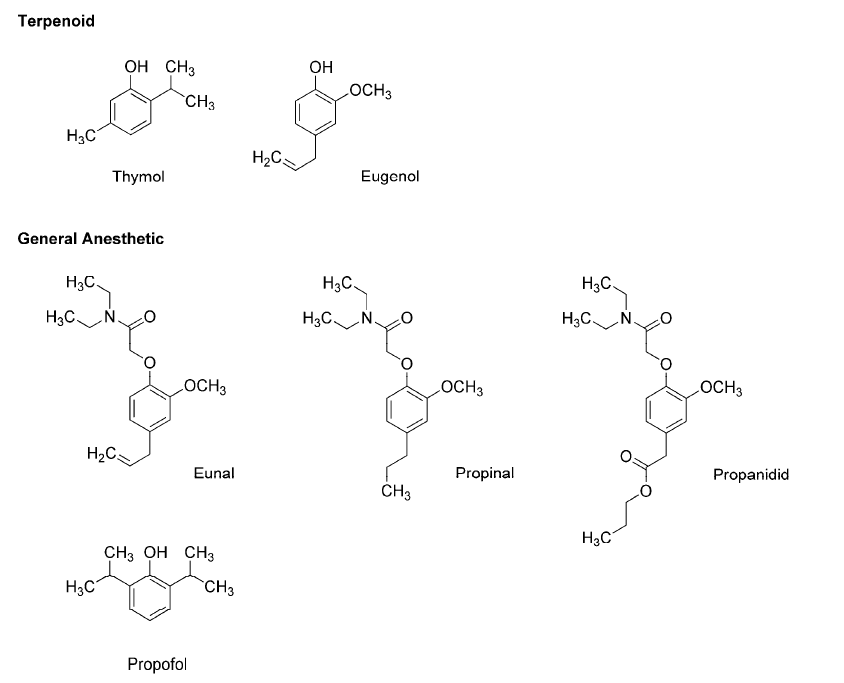
Figure 2. General anesthetics associated with plant terpenoid thymol and eugenol.